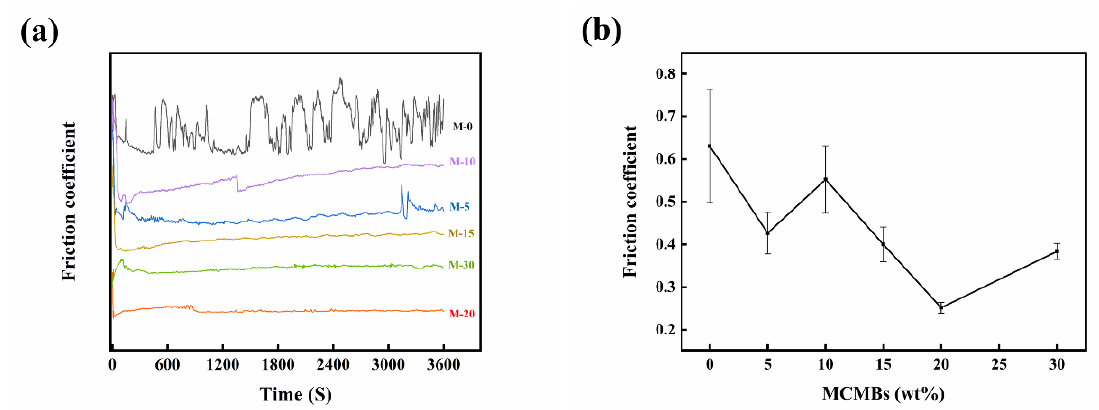
Figure 8. ( a ) Friction coefficient evolution as a function of the sliding time; ( b ) relationship between MCMB content and friction coefficient.